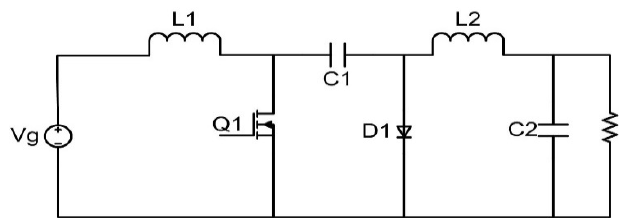
Figure 2. Circuit diagram of the Cuk converter.